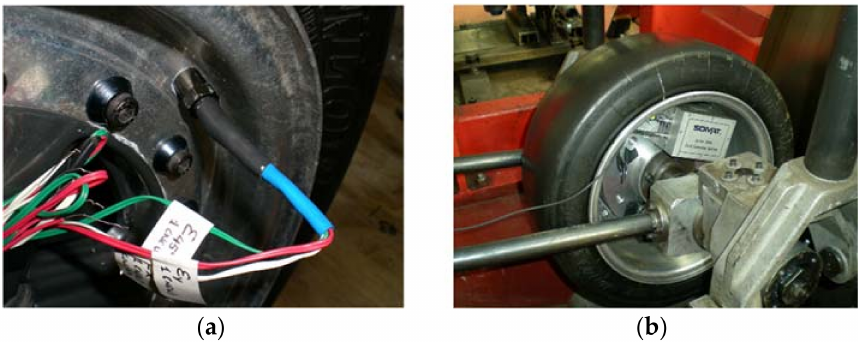
Figure 6. ( a ) Installed valves on the rim; ( b ) Installed SoMat ® 2000 in the